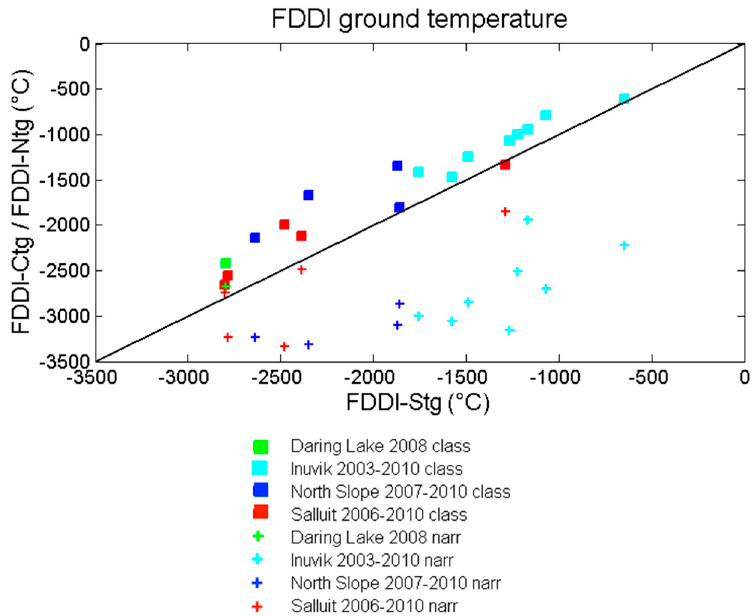
Figure 11. Mean frozen degree-day index (FDDI) of surface soil temperature (Tg) measured (FDDI-Stg), simulated with NARR (FDDI-Ntg) (cross), and simulated with CLASS (FDDI-Ctg) (square) at the four studied tundra sites (color).